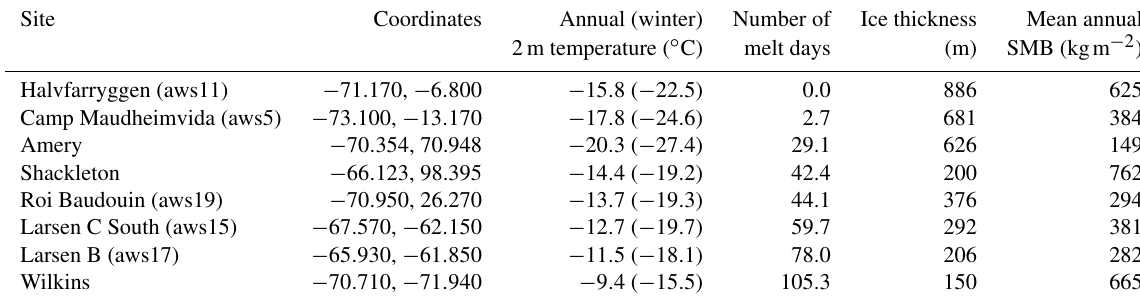
Table 1. Details of the eight sites selected to investigate the sensitivity of microwave data to meltwater. Automatic weather station (AWS) names are from Jakobs et al. (2020); temperatures are from the ERA5 reanalysis (Hersbach et al., 2020); melt days are from the AMSR2 19GHz H-pol (horizontal polarization) channel (Torinesi et al., 2003a); ice thickness is from Bedmap2 (Fretwell et al., 2013); surface mass balance (SMB) is from RACMO (Regional Atmospheric Climate Model; Van Wessem et al., 2014).